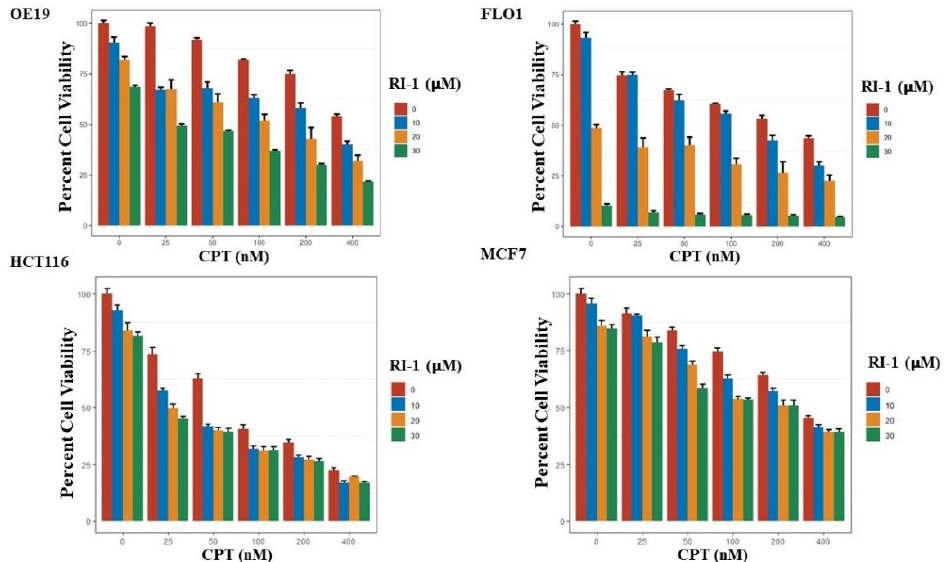
Figure 4. RAD51 inhibitor potentiates cytotoxicity of camptothecin in cancer cell lines. Esophageal adenocarcinoma (OE19, FLO-1), colon (HCT116) and breast (MCF7) cancer cell lines were treated with RAD51 inhibitor (RI-1), camptothecin (CPT) or combination of both (RI-1 + CPT) at different concentrations for 48 h and evaluated for cell viability as described in Methods. Errors bars represent SDs of triplicate assays.